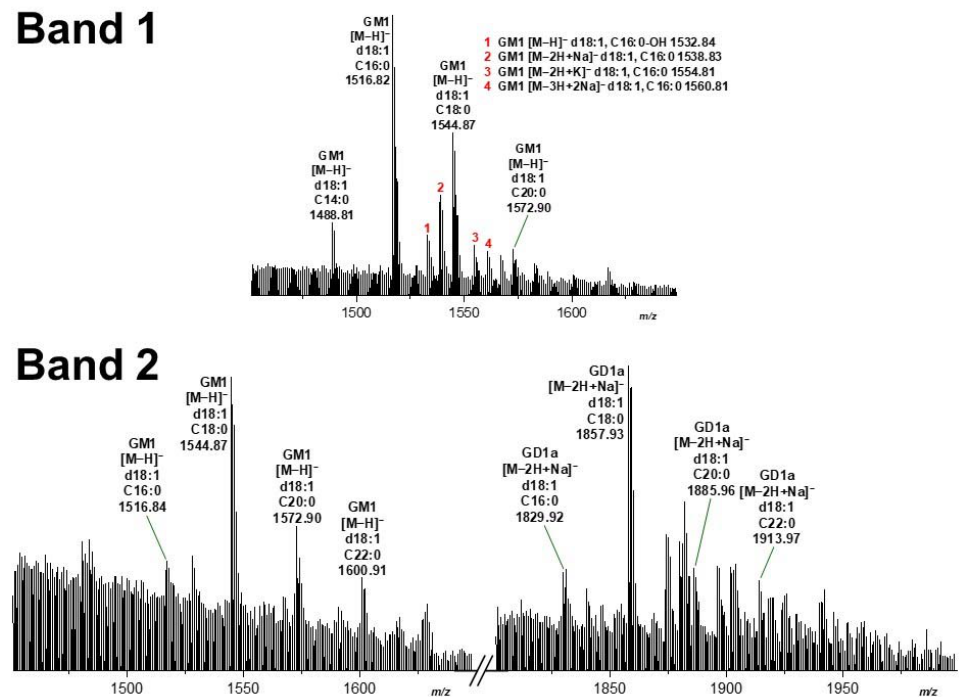
Figure 5. MS 1 spectra of choleragenoid-detected GM1 species of pHCoEpiCs at TLC positions of GM1 (Band 1) and GD1a (Band 2) after treatment with neuraminidase of Vibrio cholerae . Separated gangliosides were extracted after V. cholerae neuraminidase treatment from scraped silica gel at positions of TLC-separated GM1 and GD1a, assigned as Band 1 and Band 2, respectively, in Figure 4B. Spectra were recorded in negative ion mode. The major signals of the deprotonated [M − H] − species of GM1 and the deprotonated sodium adducts [M − 2H+Na] − of GD1a are listed in Table 2. Numbered minor species of GM1 (Band 1) are depicted on the right side of the panel.